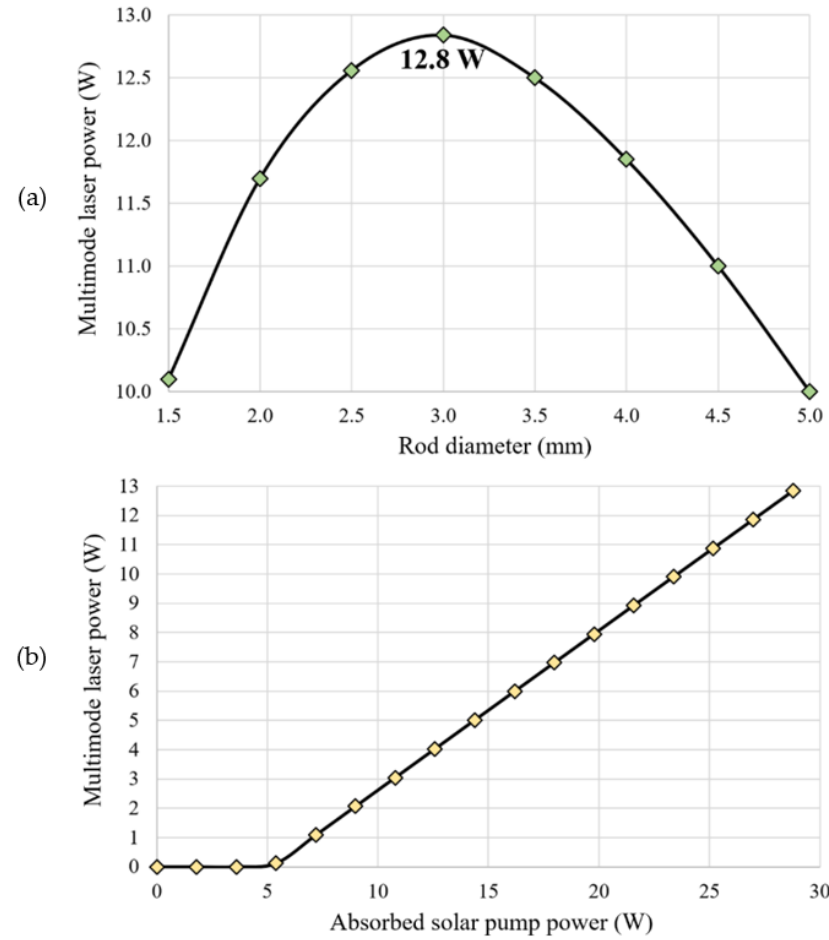
Figure 5. ( a ) Multimode laser power as a function of rod diameter. ( b ) Multimode laser power from one of the four 3.0 mm diameter, 20 mm length Nd:YAG rods as a function of absorbed solar pump power.